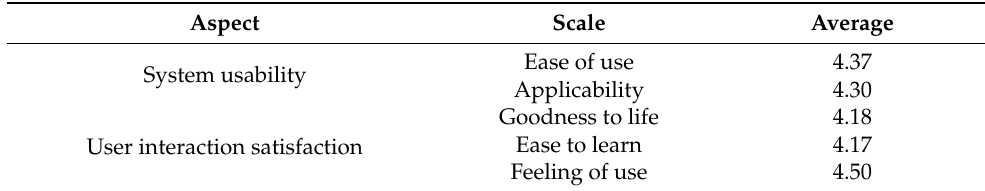
Table 6. Statistics of the average Likert scores of the scales of the aspect of system usability and user interaction